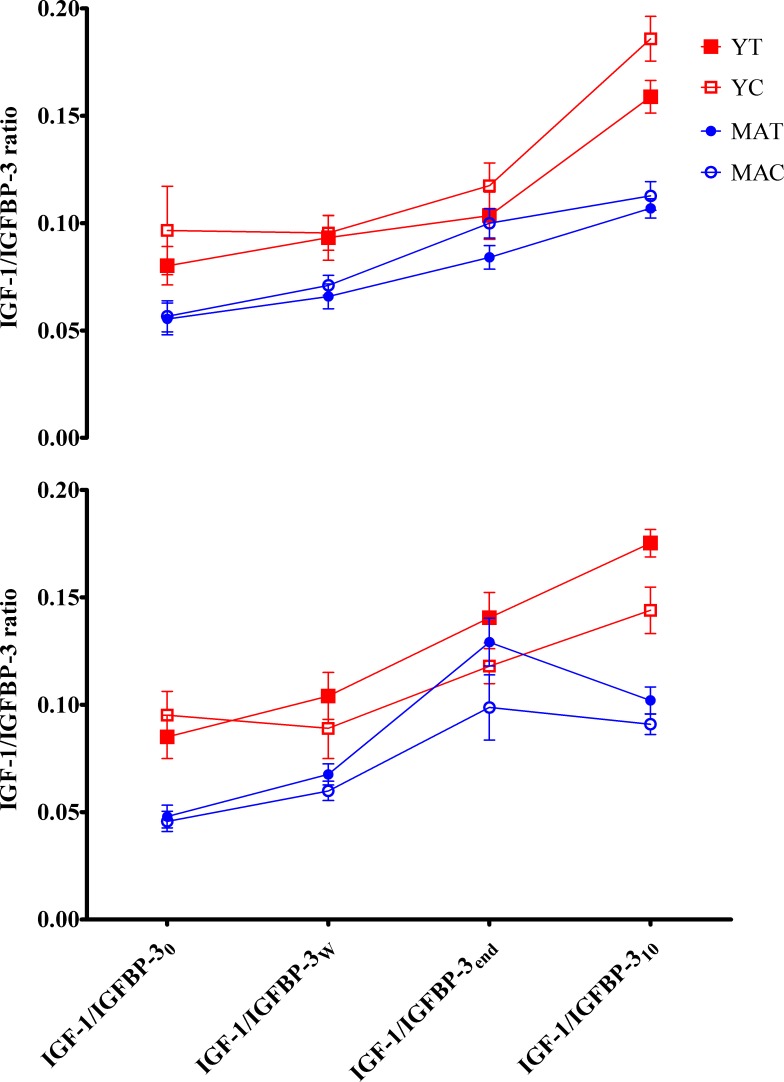
[IGF-1]/[GFBP-3] ratio changes determined before (P1; above) and after (P2; below) training.Plasma [IGF-1]/[GFBP-3] ratio at rest (0), after warm-up (w), at the end of exercise (end), and during recovery (10) in young trained (YT), young control (YC), middle-aged trained (MAT), and middle-aged control (MAC) groups. Data are presented as mean ± standard error for clarity.